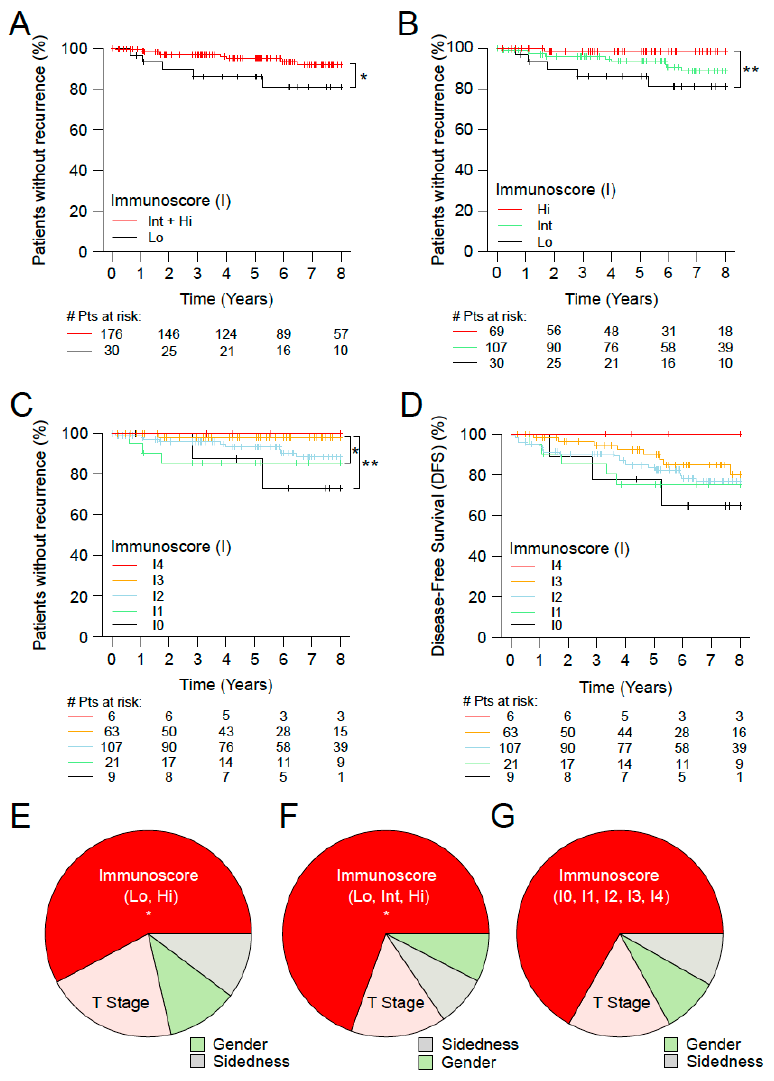
Figure 4. The impact of Immunoscore on MSS patients with Stage I colon cancer. Kaplan-Meier curves of Immunoscore (I) for TTR ( A–C ) and DFS ( D ) for Stage I MSS patients from cohorts 1 and 2. ( A ) Immunoscore two categories, Lo (0–25%, black) and Int + Hi (>25–100%, red), in Stage I MSS patients. ( B ) Immunoscore three categories, I Lo (0–25%, black), I Int (>25–70%, green) and I Hi (>70– 100%, red), in Stage I MSS patients. ( C,D ) Immunoscore five categories, I0 (0–10%, black), I1 (>10– 25%, green), I2 (>25–70%, azure), I3 (>70–95%, orange) and I4 (>95–100%, red), in Stage I MSS pa- tients. Relative importance of each risk parameter to survival risk for TTR using the χ 2 proportion test for clinical parameters and Immunoscore in two ( E ), three ( F ) and five categories ( G ). Significant logrank p -values are marked as, ** 0.001 < p ≤ 0.01, * 0.01 < p ≤ 0.05. 4. Discussion